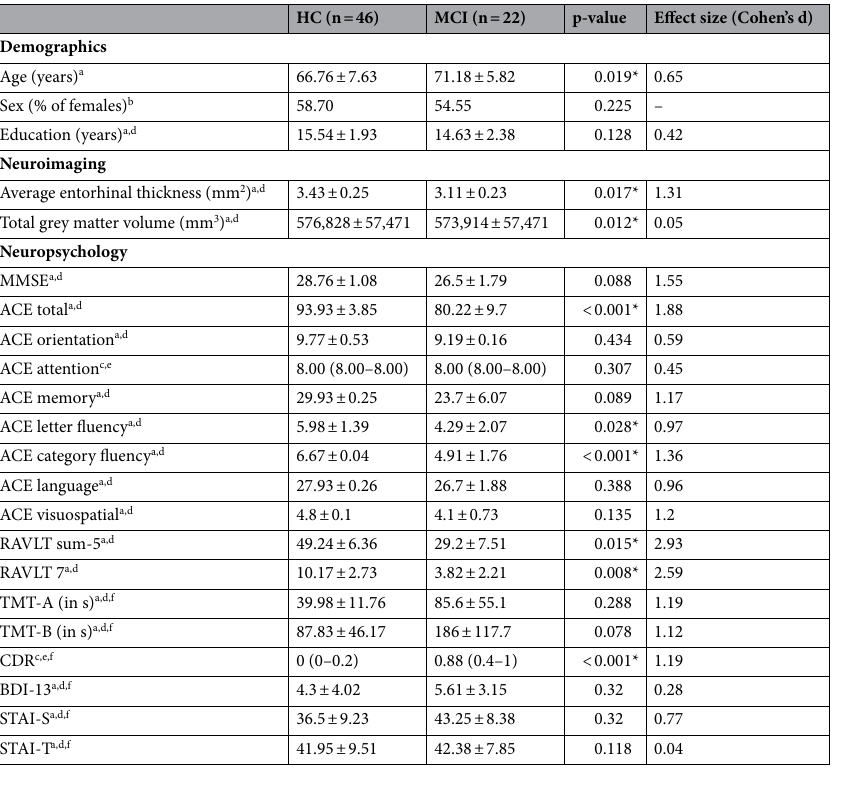
Table 2. Demographic, clinical, and neuropsychological characteristics of the HC and MCI groups. HC healthy control, MCI mild cognitive impairment, MMSE Mini-Mental State Examination, ACE Addenbrooke Cognitive Examination, RAVLT Rey Auditory Verbal Learning Test, TMT Trail-Making Test, CDR Clinical Dementia Rating scale, BDI Beck Depression Inventory, STAI-S Spielberger State and Trait Anxiety Inventory State Score, STAI-S Spielberger State and Trait Anxiety Inventory Trait Score. *Indicates significant differences (p < 0.05). a Data was analyzed with independent sample t-test. b Data was analyzed with Chi-squared test. c Data was analyzed with Mann–Whitney U-test. d Data is given in the form of mean ± standard deviation (SD). e Data is given in the form of median and interquartile ranges (IQ1–IQ3). f Lower score associates with better cognitive